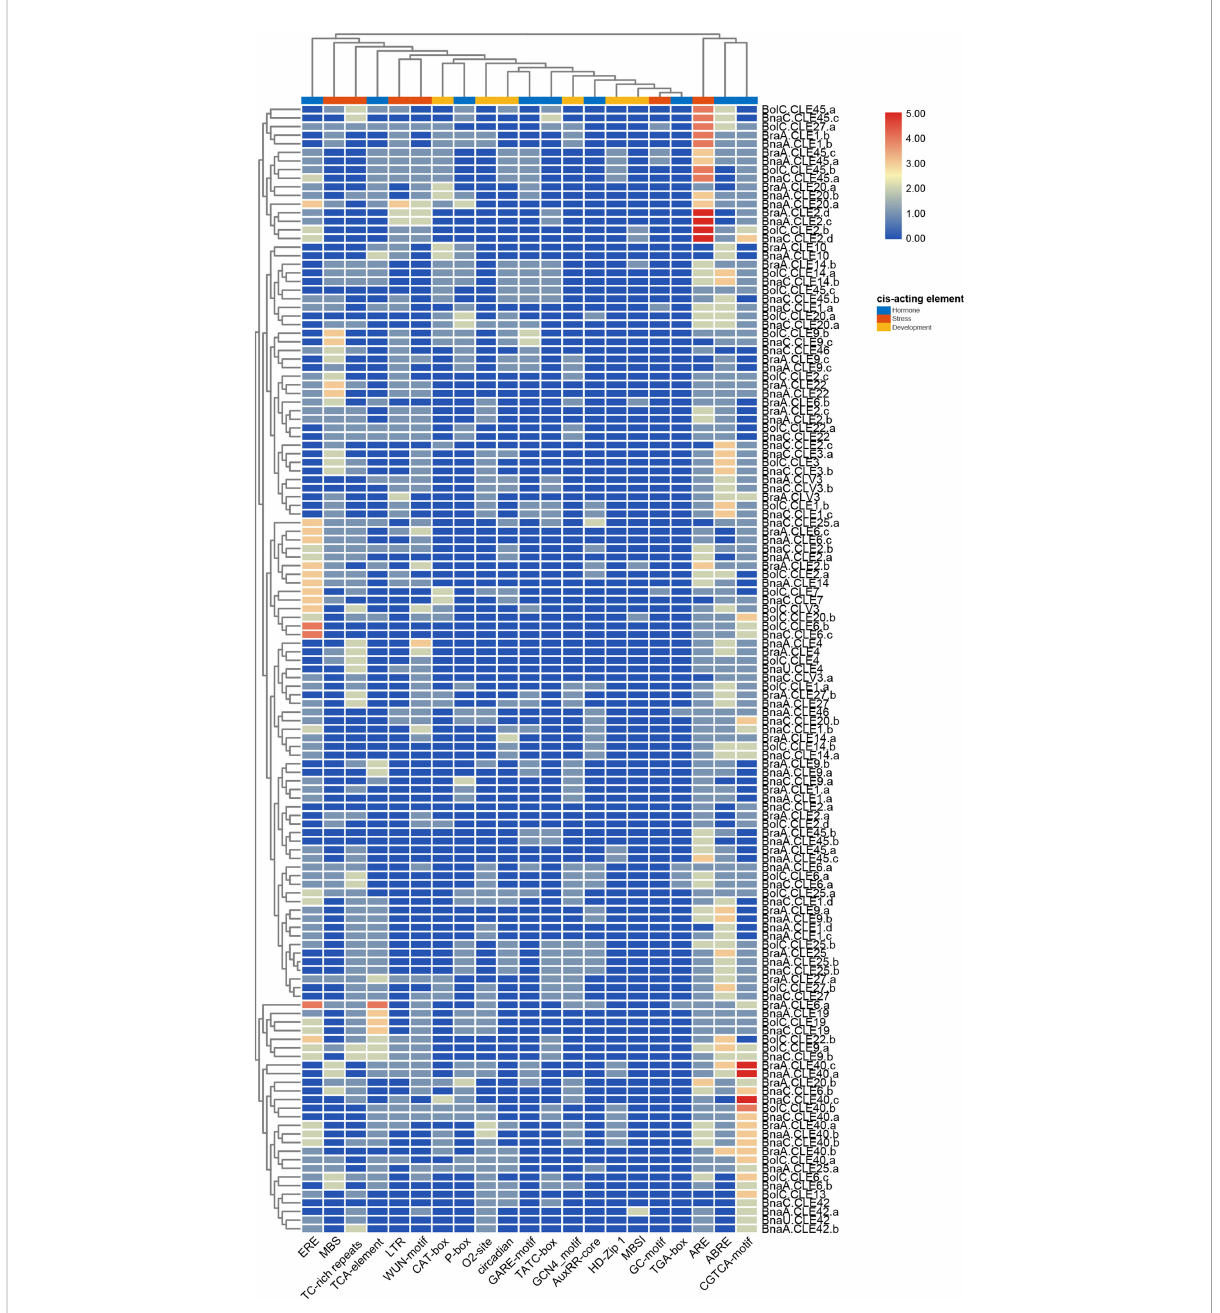
FIGURE 4 Cis -acting elements analysis of CLE s in Brassica napus , Brassica rapa , and Brassica oleracea . The color scale bar indicates the numbers of cis - acting elements in the